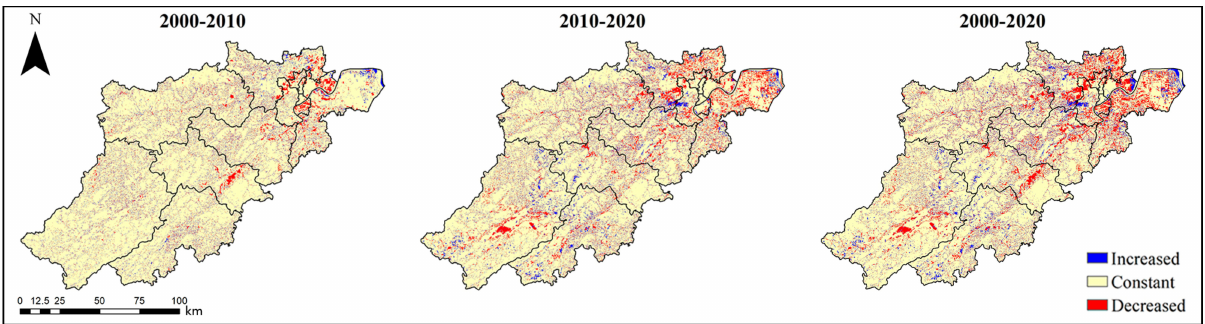
Figure 4. Spatial distribution of carbon storage in Hangzhou from 2000 to 2020.